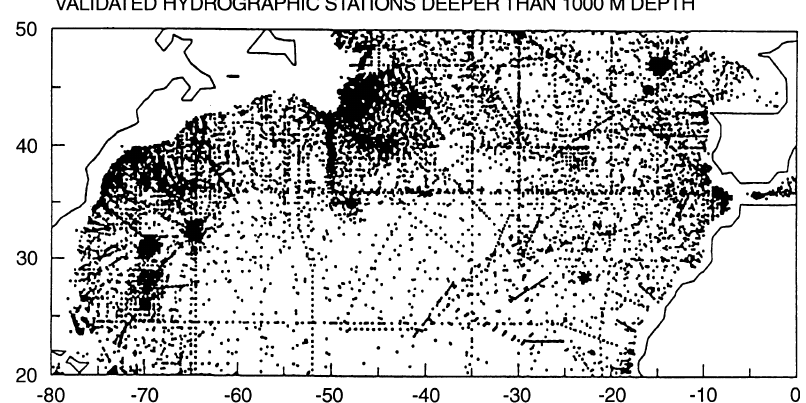
Fig. 3. Distribution, after quality control, of the hydrographic stations in the data compi- lation that are deeper than 1000